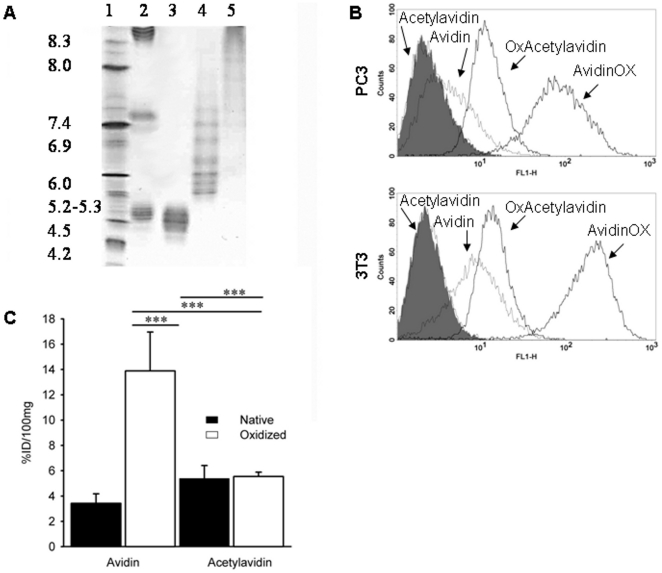

In vitro binding and in vivo residence of acetylated avidin.
A, Isoelectric focusing of acetylated avidin. Lane 1, IEF standards; Lane 2, Herceptin, streptavidin and ovalbumin mixture; Lane 3, Acetylated avidin 1∶80; Lane 4, Acetylated avidin 1∶40; Lane 5, Acetylated avidin 1∶20. B, Cells were incubated with 150 µM avidin, AvidinOX, acetylated avidin pI 4.7 (Acetylavidin) or oxidized acetylated avidin (OxAcetylavidin) at +4°C and binding revealed by cytofluorimetry with an anti-avidin antibody as detailed in Materials and Methods. Gray peaks are background (second antibody, only). Thin and bold lines, native and oxidized glycoproteins, respectively. C, Avidin and acetylated avidin pI 4.7 (Acetylavidin), were 125I-labeled and then oxidized with sodium periodate as described in Materials and Methods. All samples were diluted at 3.0 mg/ml in sodium acetate pH 5.5 and 15 µl were injected intramuscularly in one hind limb of mice. After 24 hours, the mice were sacrificed and treated limbs collected, weighed and counted in a gamma counter. Data are expressed as the % of injected dose/100 mg (% ID/100 mg) of tissue. Each point is the average of 5 mice. Bars represent standard deviation. Statistical analysis by Student's t test. ***p<0.001.